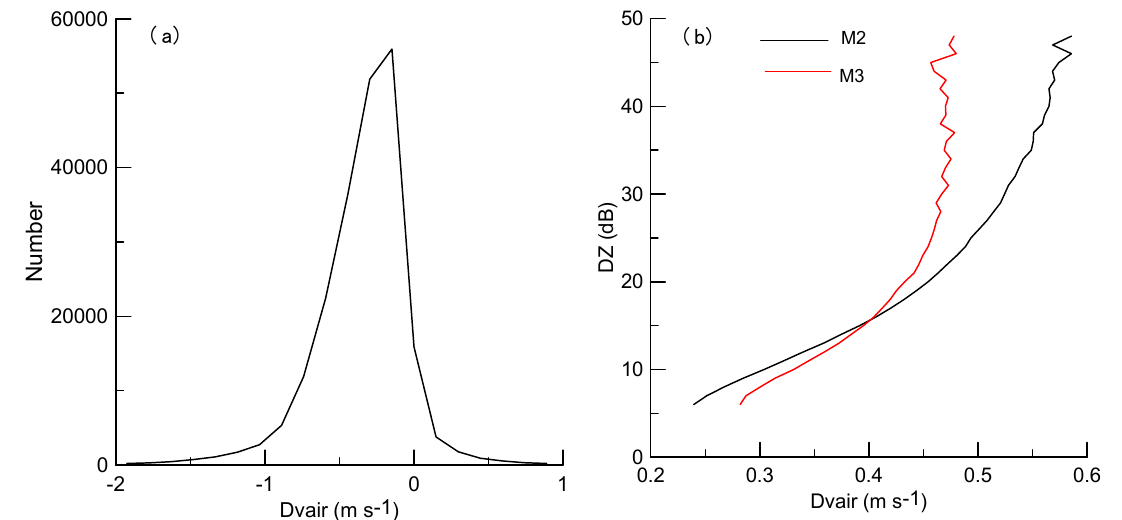
Figure15. DistributionsofthebiasesoftheverticalairmotionsretrievedbyM2andM3( a ); thevariations Figure 15. Distributions of the biases of the vertical air motions retrieved by M2 and M3 ( a ); the of the averaged biases in vertical air motions with the signal level di ff erence ( b variations of the averaged biases in vertical air motions with the signal level difference ( b ).